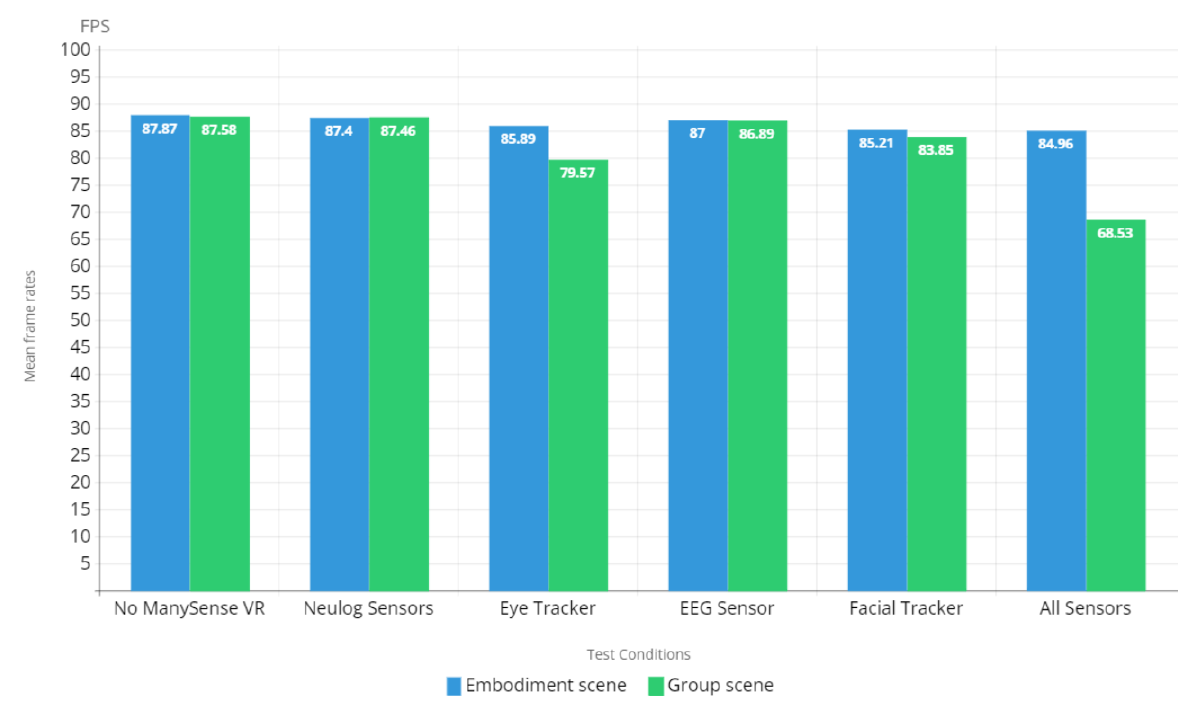
Figure 11. Mean frame rates (FPS) for each test condition and